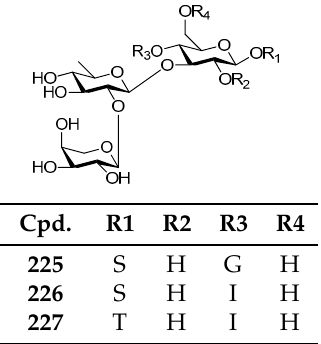
Figure 39. Structure of compound 224 .